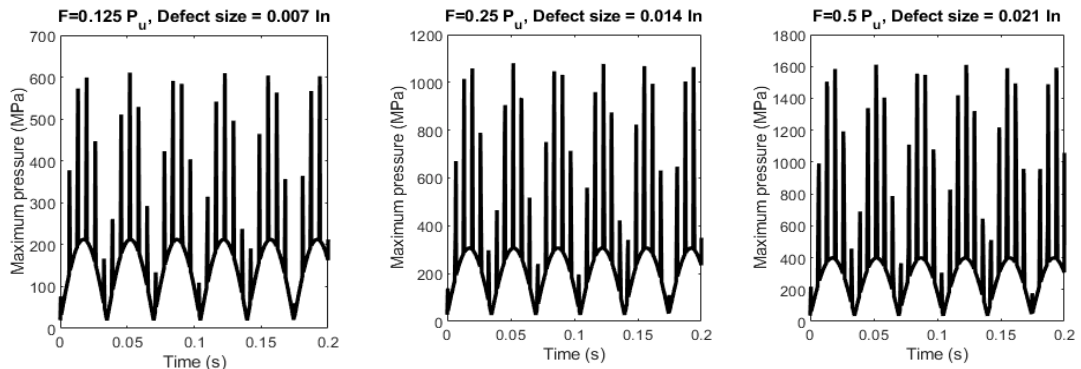
Figure 4. Examples of the computed time histories for different load levels and defect sizes.